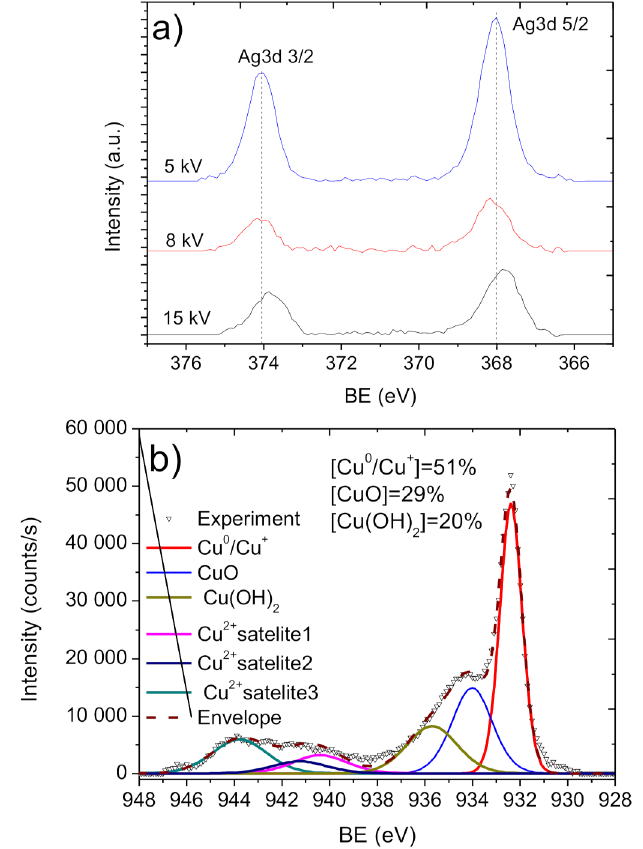
Figure 8. XPS Ag3d ( a ) spectra of PCL-Ti0.5-Ag15kV, PCL-Ti0.3-Ag8kV and PCL-Ti0.3-Ag5kV samples and Cu2p ( b ) spectrum of the PCL-Cu